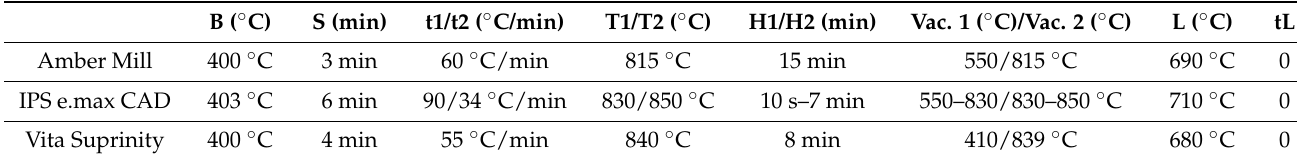
Figure 1. Reference cast. Table 2. Crystallization parameters of the materials used in the present